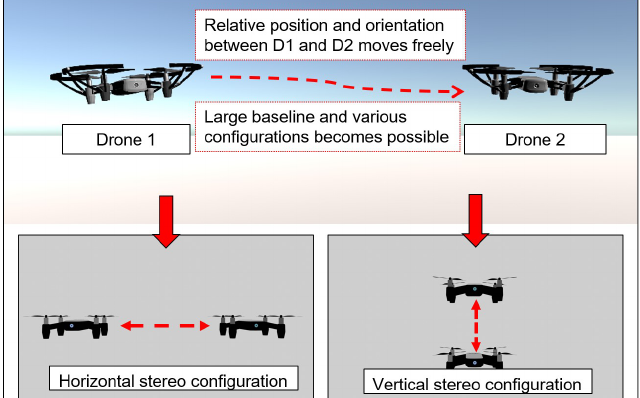
Figure 3. The possibility of changing multiple setups of the flexible configuration